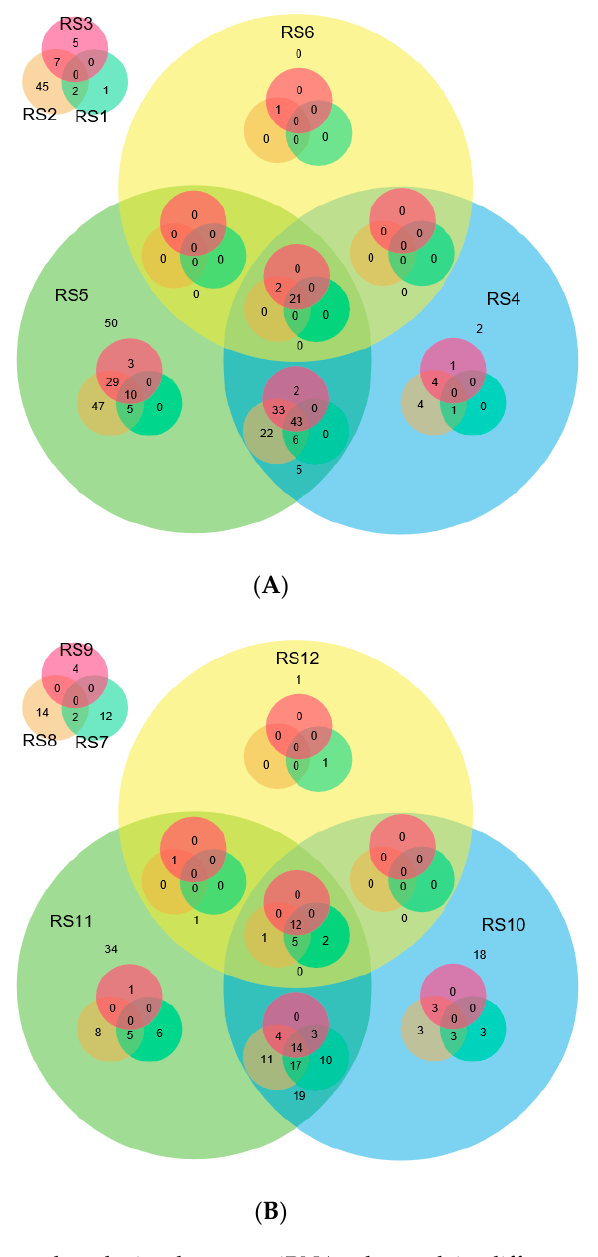
Figure 1. Common and exclusive known miRNAs detected in different small RNA libraries. ( A ) Venn diagram showing the common and unique miRNAs expressed under the R. solani infection condition. ( B ) Venn diagram showing the common and unique miRNAs under the control condition. Infected